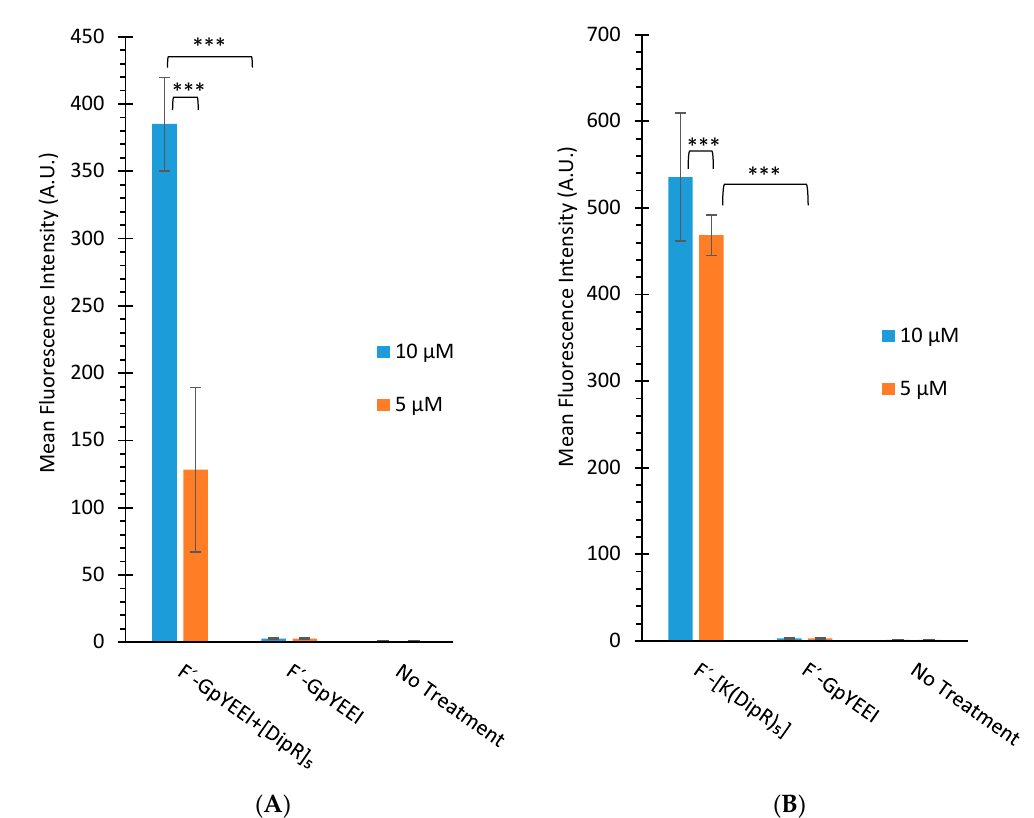
Figure 10. ( A ) The cellular uptake study of F’-GpYEEI (2 µM) in the presence of [DipR] 5 (5 or 10 µM) in CCRF-CEM cells and ( B ) the cellular uptake of F’-[K(DipR) 5 ] (5 or 10 µM) in CCRF-CEM cells after 3 h incubation. Results are mean ± SD (n = 3) (*** p < 0.001). We also examined the cellular uptake of F’-[K(DipR) 5 ] at different concentrations (10 µM and 5 µM). The uptake of F’-[K(DipR) 5 ] showed slight concentration dependence up- take. The uptake of F’-[K(DipR) 5 ] (10 and 5 µM) have values of 179 and 154-fold increase for 10 and 5 µM within 3 h, respectively, as compared to F’-GpYEEI (2 µM) (Figure 10B). To explore the cellular uptake mechanism of action, another study was conducted in the presence of endocytosis inhibitors such as nystatin, chlorpromazine, chloroquine, and methyl β -cyclodextrin to determine whether the cellular uptake of F’-[K(DipR) 5 ] alone and F’-GpYEEI in the presence of [DipR] 5 were endocytosis-dependent. None of the endocy- tosis inhibitors completely inhibited the cellular uptake. Chloroquine and nystatin re- duced slightly 1.9–1.3-fold the uptake of F’-GpYEEI (2 µM) in the presence of [DipR] 5 (10 µM) (Figure 11A). Likewise, endocytosis inhibitors chloroquine and nystatin reduced the cellular uptake of F’-[K(DipR) 5 ] (10 µM) slightly by 1.3 and 1.5-fold, respectively (Figure 11B). The results suggest that a combination of multifaceted mechanisms could contribute to the uptake of F’-[K(DipR) 5 ] alone and F’-GpYEEI in the presence of [DipR] 5 across the plasma membrane.